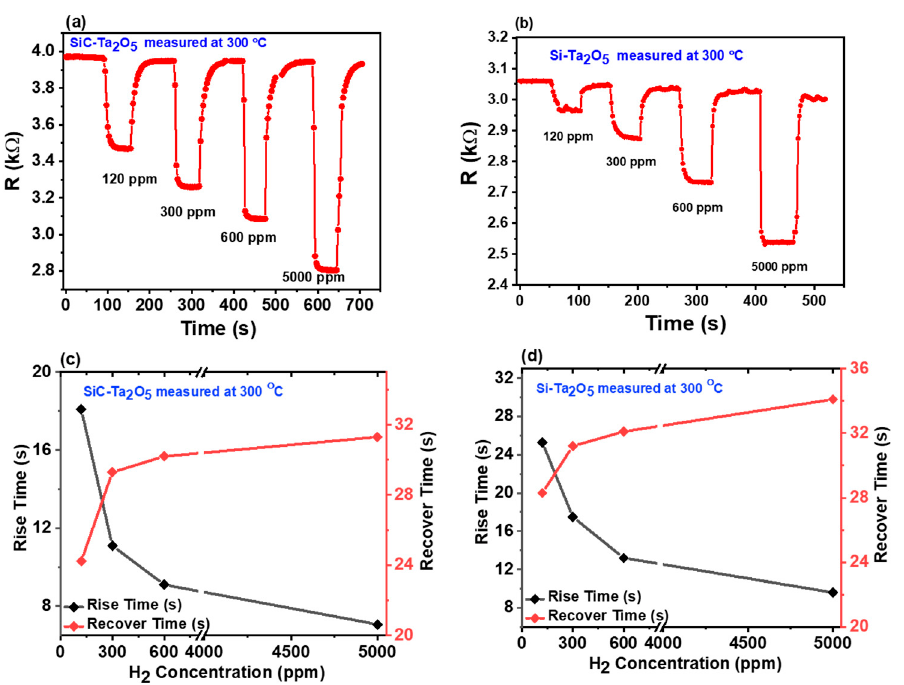
Figure 5. The time-dependent behavior (response and recovery time) of ( a ) the Pd/Ta 2 O 5 /SiC device and ( b ) the Pd/Ta 2 O 5 /SiC device under various H 2 concentrations at 300 °C. Rising and recovery time Vs H 2 concentration for (c) Pd/Ta 2 O 5 /SiC device and (d) the Pd/Ta 2 O 5 /Si device